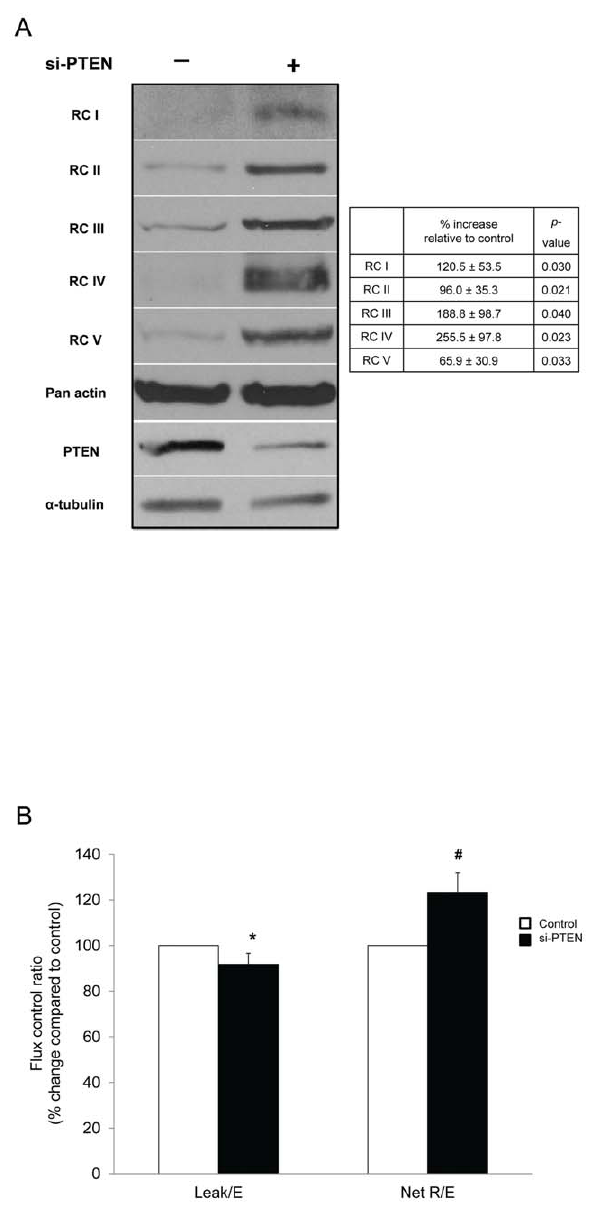
Figure 3. RNA-silencing PTEN in MEF WT . ( A ) Western blot analyses of respiratory complexes The protein expressions of all five RCs were significantly up-regulated by si-RNA of PTEN. A higher degree of increase in RCI, III and IV, as compared to RCII and V was apparent (inset). ( B ) Oxygen consumption si-RNA of PTEN was accompanied by an increase in the net oxygen consumption expressed as NetR/E and a decreased Leak/E when compared to untreated MEF WT . * p , 0.05, # p , 0.005 for